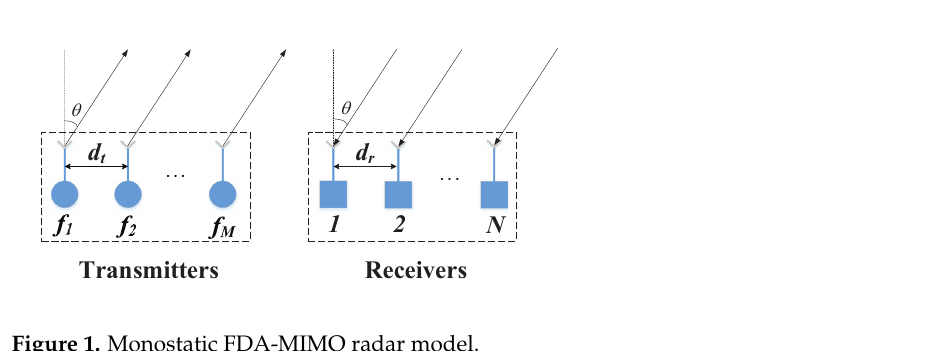
Figure 1. Monostatic FDA-MIMO radar